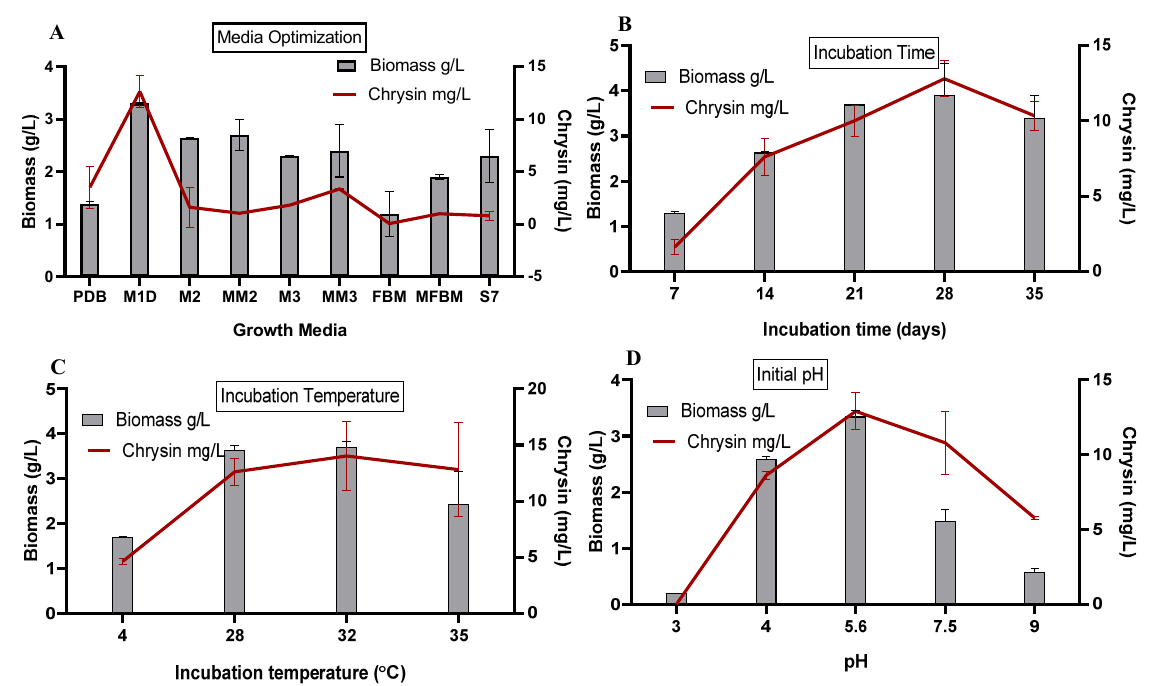
Figure 1. Effect of fermentation parameters on biomass and chrysin production in the suspension culture of C. globosum . ( A ) Media optimization; ( B ) Incubation time; ( C ) Incubation temperature; ( D ) Initial pH.